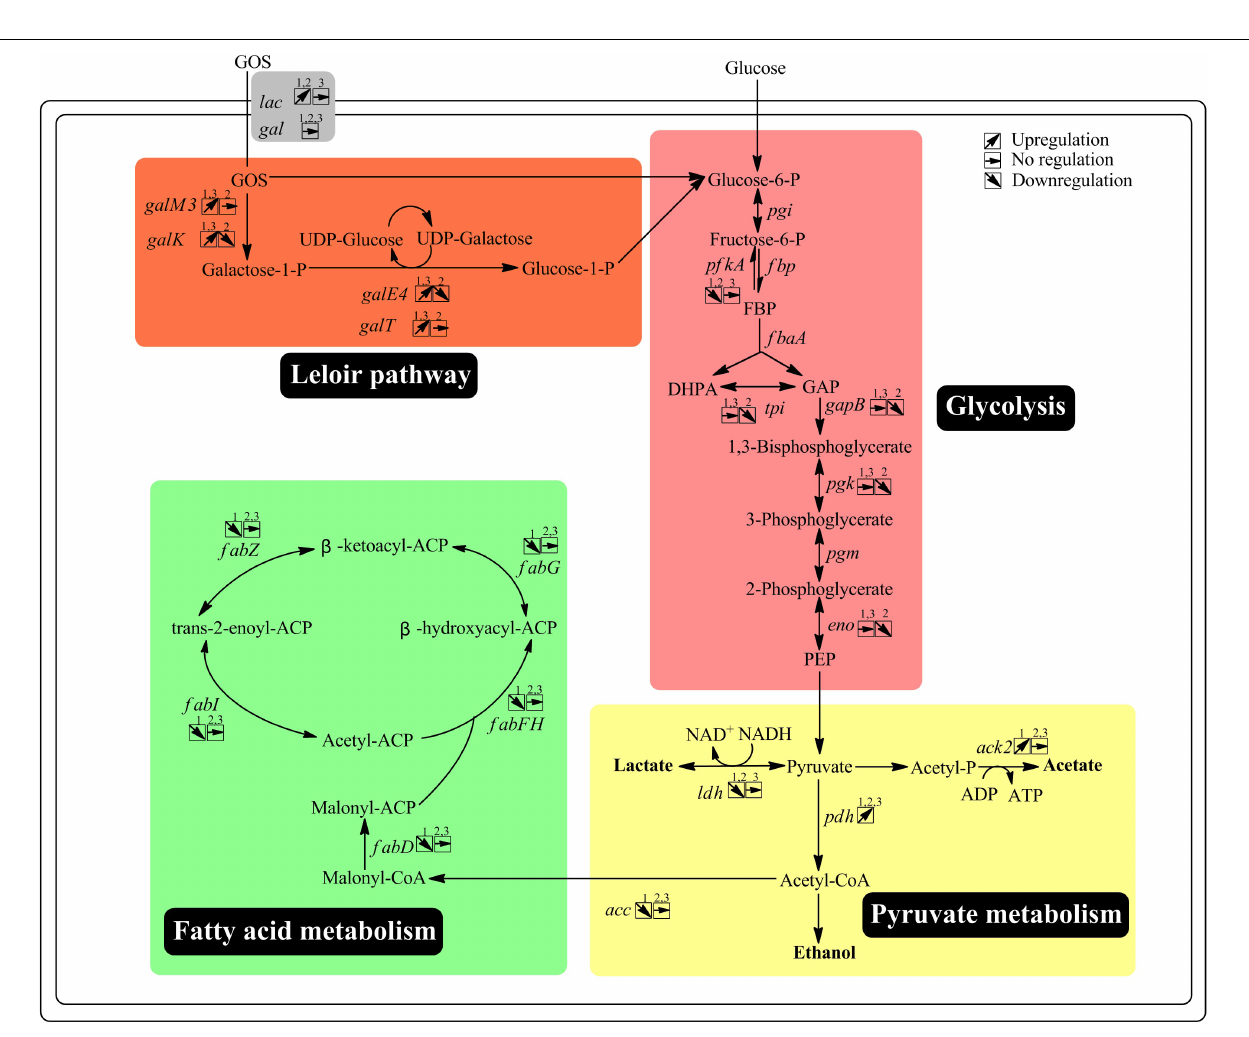
Frontiers in Microbiology |